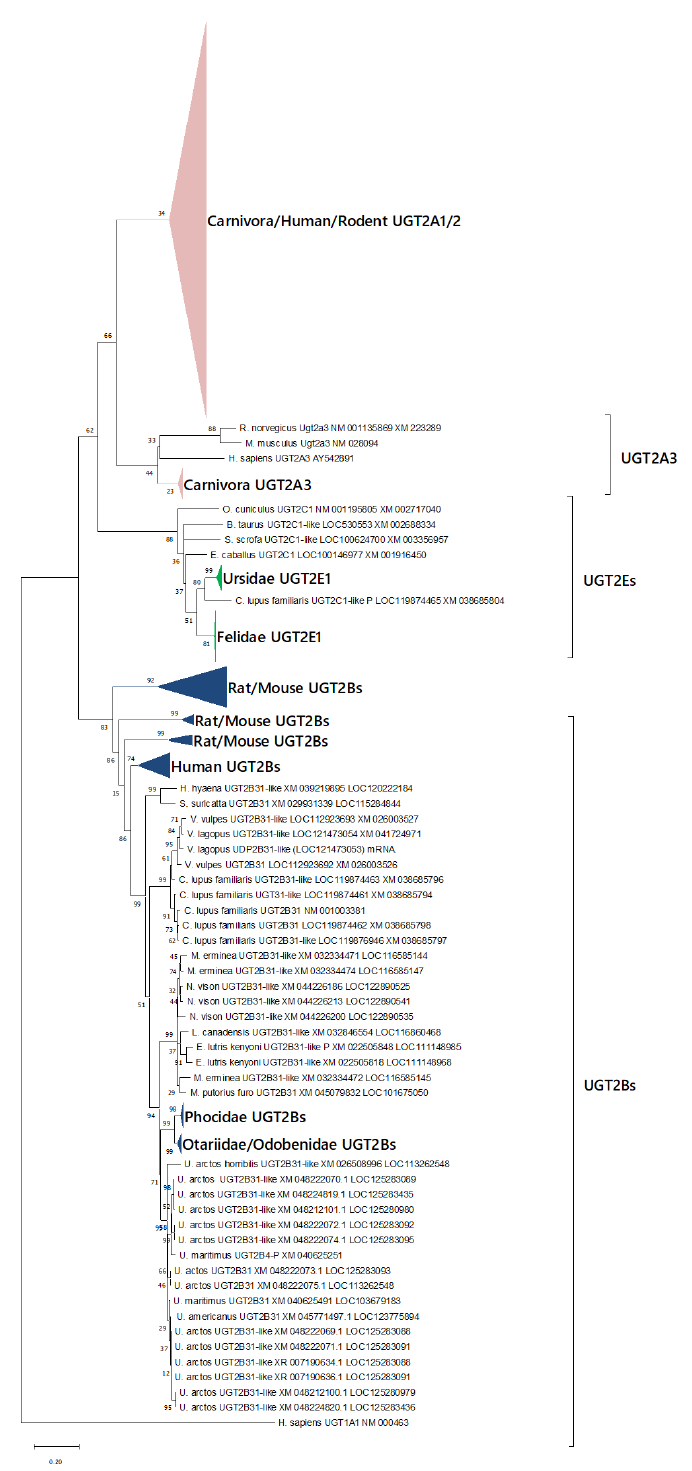
Figure 5. Phylogenetic tree of UGT2s. Phylogenetic tree of UGT2s sequences in human, mouse, rat, and carnivorans. Gene sequences of protein-coding regions for each isozyme were analyzed. The numbers next to the branches indicate the number of occurrences per 100 bootstrap replicates. Genes and clades are tentatively labeled with carnivoran UGTs examined in this article. Clades of rodent and human UGT2As, UGT2Bs, and UGT2Es in the phylogenetic tree are shown as triangles of the following colors: navy for UGT2Bs, green for UGT2Es, and pink for UGT2As. UGT1As are shown as an